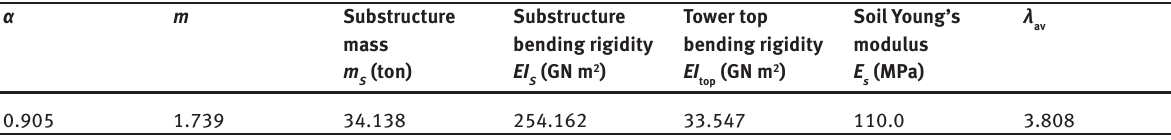
Table 5: Adopted values for computing the 1st NF at North Hoyle.